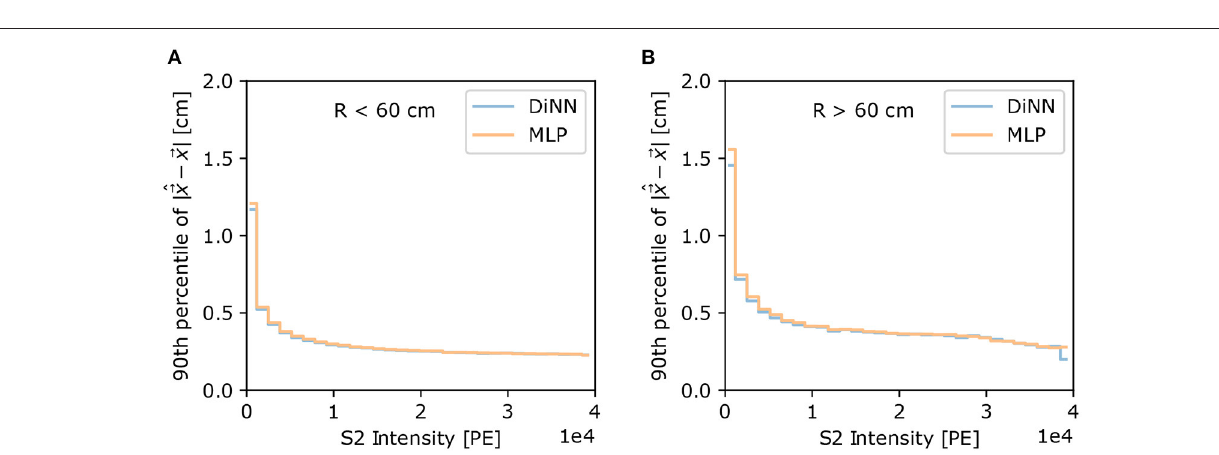
Frontiers in Artificial Intelligence |